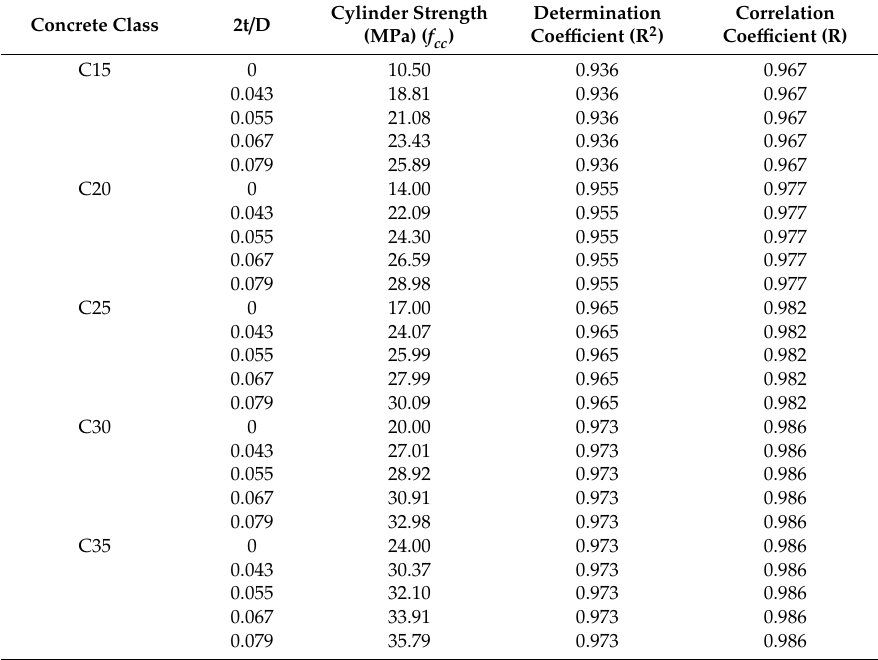
Table 8. Predicted strength for di ff erent concrete classes and 2t / D